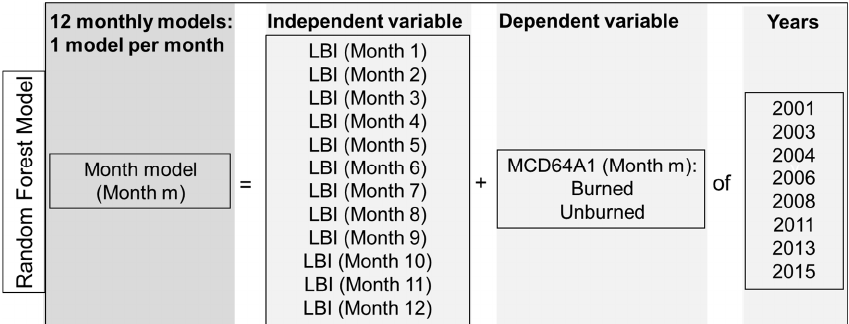
Figure 9. Representation and composition of the random forest model. Twelve monthly models